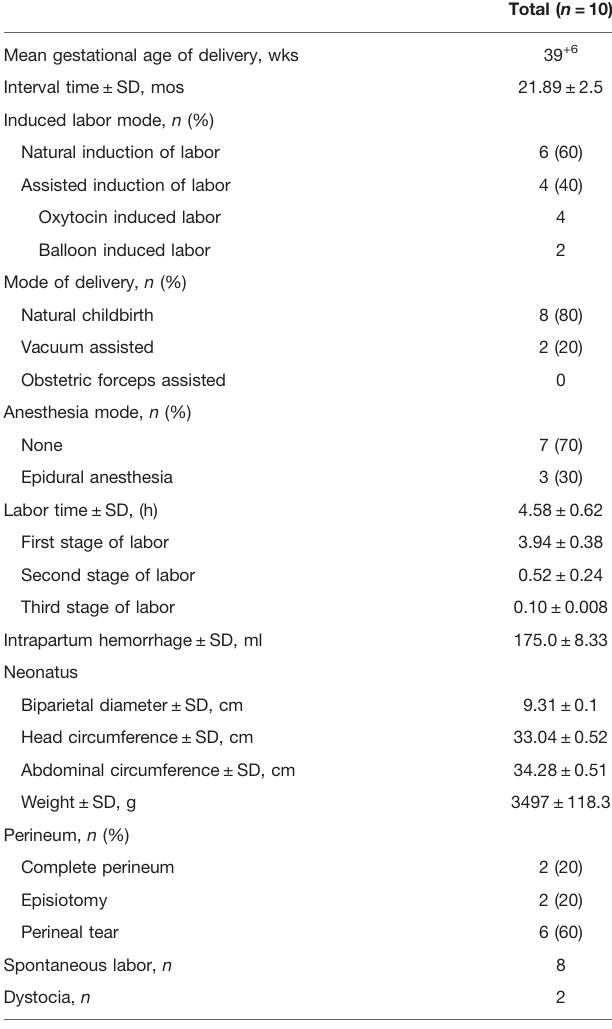
TABLE 3 | Obstetric delivery outcomes of 10 patients undergoing vaginal